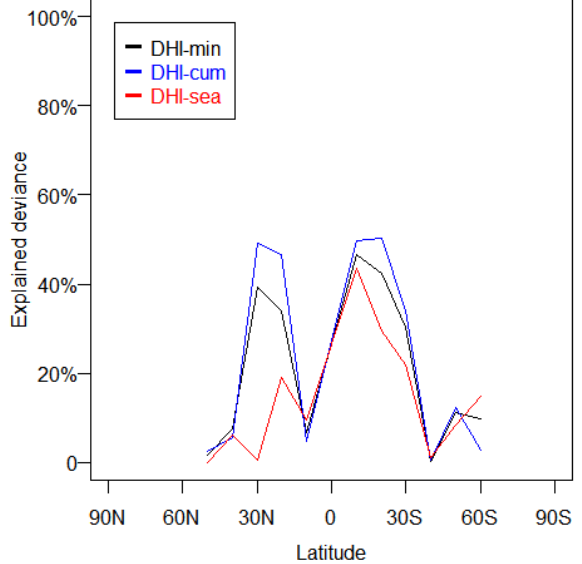
Figure 4 The explained variance of DHI metrics on mammal richness at latitudinal zones (360° × 10°). For DHI-min and DHI-cum, univariate linear regression was used to calculate the explained variance. For DHI-sea, linearization was achieved by taking the log of the data before using univariate linear regression to calculate the explained variance. The measured values were obtained for 10,000 0.1-degree pixels randomly selected from global terrestrial areas.